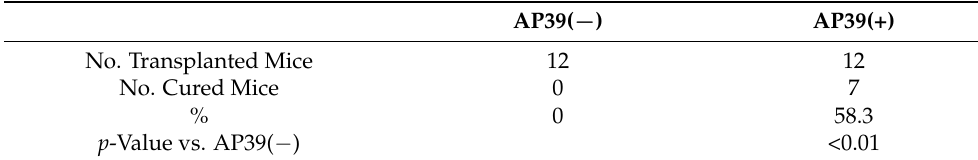
Table 3. In vivo functional